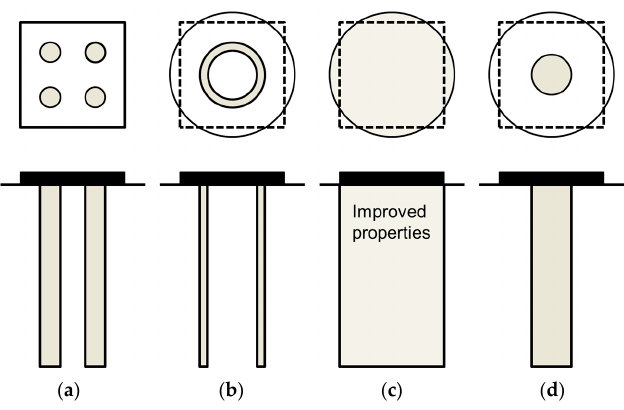
Figure 15. Simplified geometrical model for groups of stone columns beneath a square footing: ( a ) 3D model; ( b ) Gravel rings; ( c ) Homogenization; ( d ) One central column. 10. Critical Column Length